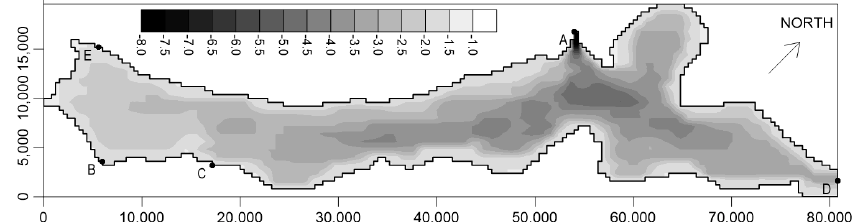
Figure 2. Simplified shape and bathymetry (m a.s.l.) of the Vistula Lagoon (in meters) [4]: A—Strait of Baltiysk, B—Nowakowo, C—Tolkmicko, D—Kaliningrad, E—Nowy Ś wiat. of Baltiysk, B—Nowakowo, C—Tolkmicko, D—Kaliningrad, E—Nowy